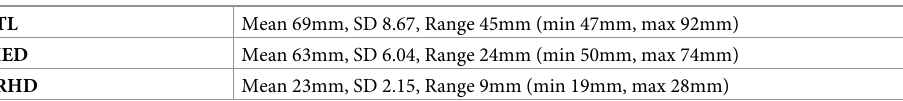
Fig 5. Tendon length and gender. This histogramm shows the distribution of the tendon length in general (yellow curve; mean value of 69mm), in women (violett; mean value of 64mm) and in men (blue; mean value of 71mm). https://doi.org/10.1371/journal.pone.0257057.g005 Table 2. Basic dimensions.